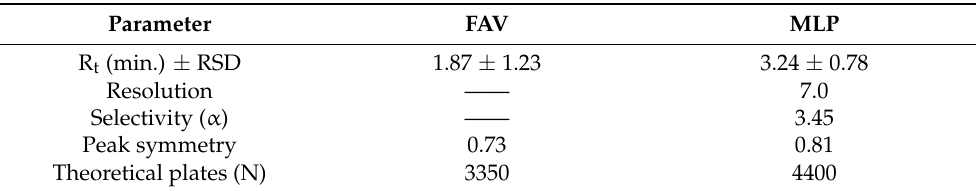
Table 5. System suitability and validation results for determination of FAV and MLP under the proposed LC method. Table 4. Calculated validation parameters for the developed chemometric models.